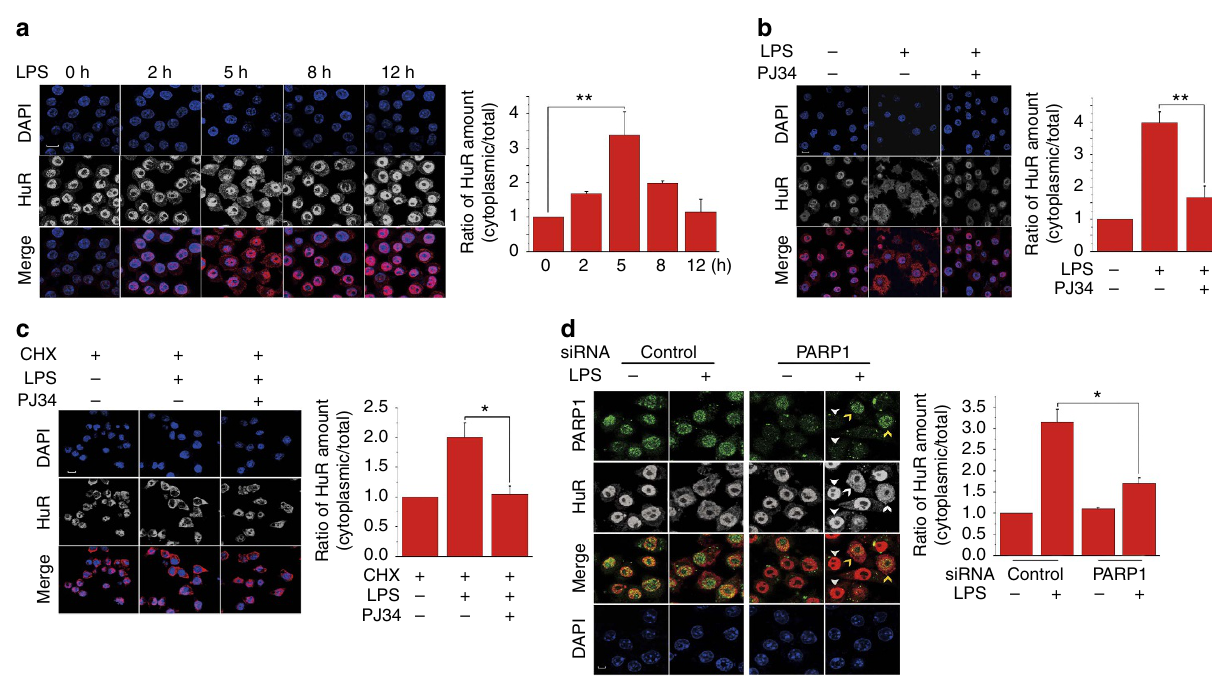
Figure 4 | Role of PARP1 in HuR’s nucleocytoplasmic shuttling in LPS-exposed cells. ( a ) LPS stimulation induces the nuclear export of HuR. RAW 264.7 were challenged with LPS for various lengths of time. The subcellular distribution of HuR is determined by immune-fluorescence (IF) staining. Scale bar, 10 m m. ( b ) PARP1 inactivation blocked HuR’s nucleocytoplasmic shuttling, which was induced by LPS. RAW 264.7 cells were mock-challenged or LPS- exposed ( ± PJ34) for 5h. The subcellular distribution of HuR was determined by IF staining. Scale bar, 10 m m. ( c ) The increased cytoplasmic level of HuR is not due to its enhanced protein synthesis. RAW 264.7 cells were exposed to LPS for 1h, and then subjected to protein synthesis inhibition by the addition of cycloheximide (CHX, 10 m gml (cid:2) 1 ). Cells withdrawn from LPS (left), maintained in LPS incubation (middle) or treated with LPS þ PJ34 (right) were fixed, and IF staining was conducted to detect the distribution of HuR. Scale bar, 10 m m. ( d ) PARP1 silencing prevents HuR’s nucleocytoplasmic shuttling that is induced by LPS. RAW 264.7 cells were transfected with control or siRNA-targeting PARP1 and then challenged with LPS for 5h. The expressions and distributions of PARP1 and HuR were visualized by IF staining. Scale bar, 10 m m. The cytoplasmic distribution of HuR was quantified by densitometry